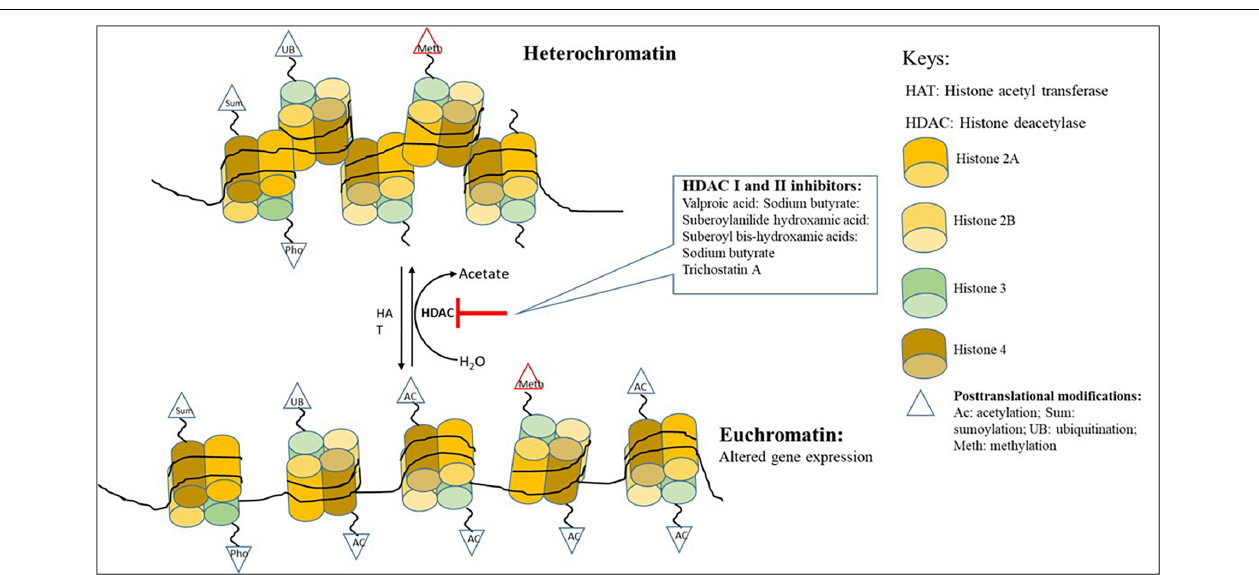
FIGURE 1 | Chromatin remodeling showing the changing of heterochromatin to euchromatin with the addition of HDAC